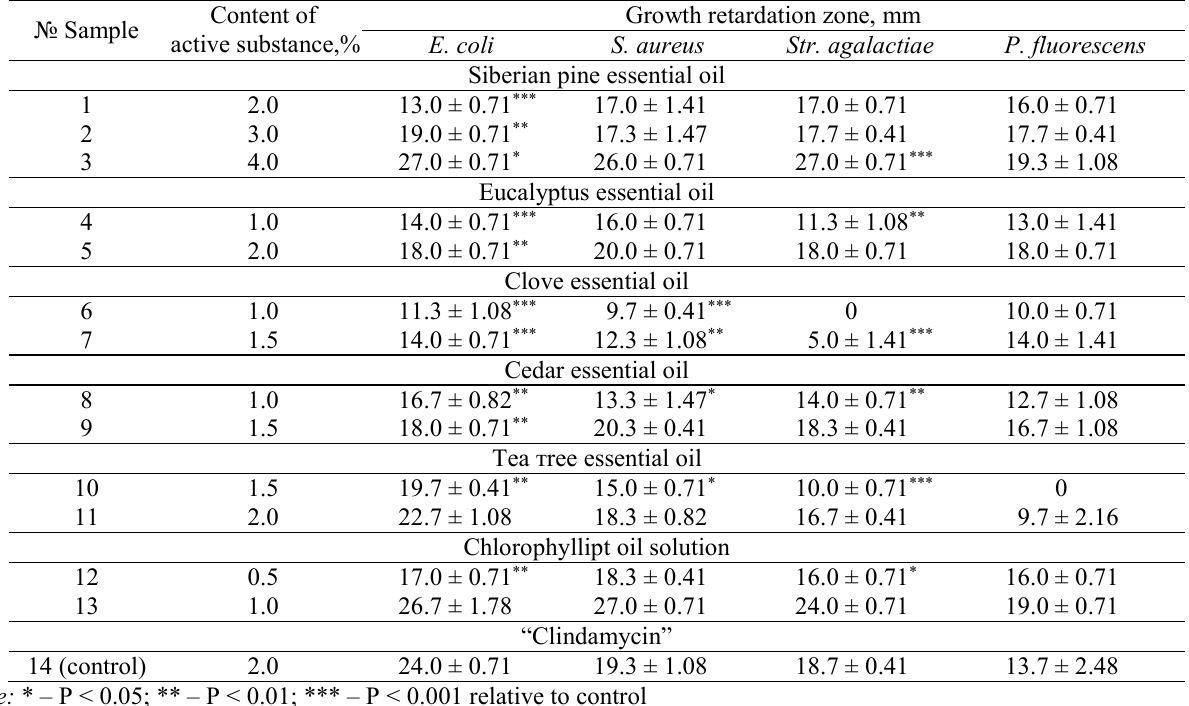
Table 1 Antimicrobial Activity of Different Concentrations of Essential Oils and Chlorophyllipt Oil, M ± m, n = 3 № Sample